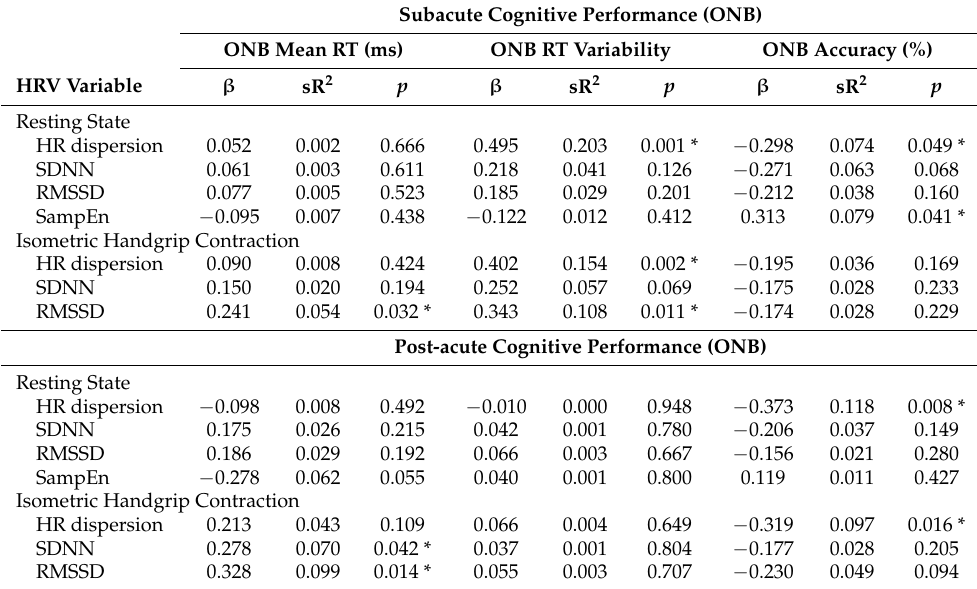
Table 9. Multivariate regression analyses for One-Back task (ONB) a